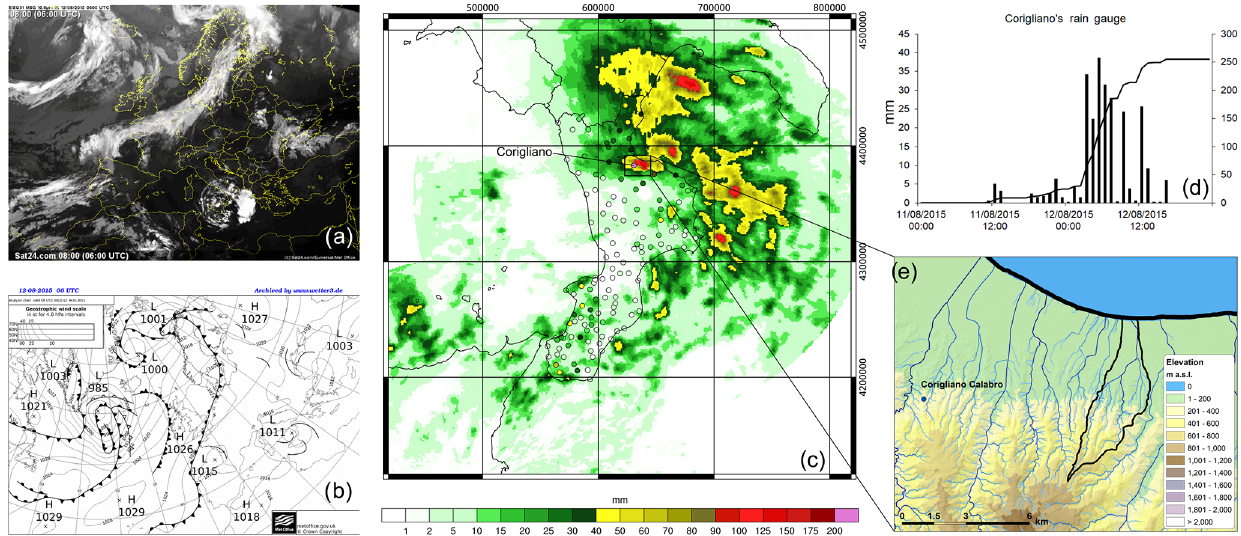
Figure 1. (a) Satellite images of the thermal infrared channel (10.8µm) at 06:00UTC on 12 August 2015 from http://www.sat24.com (last access: 5 December 2019), © EUMETSAT. (b) Surface pressure and weather fronts at 06:00UTC on 12 August 2015 from http://www1. wetter3.de/ (last access: 5 December 2019), © Met Office. (c) Cumulative rain (mm) observed between 18:00UTC 11 on August 2015 and 18:00UTC on 12 August 2015; the points represent the weather stations, whereas spatially distributed values represent the radar estimation. (d) Cumulative and hourly rainfall (mm) observed at the Corigliano rain gauge. (e) The Citrea Creek catchment, showing the location of the Corigliano rain